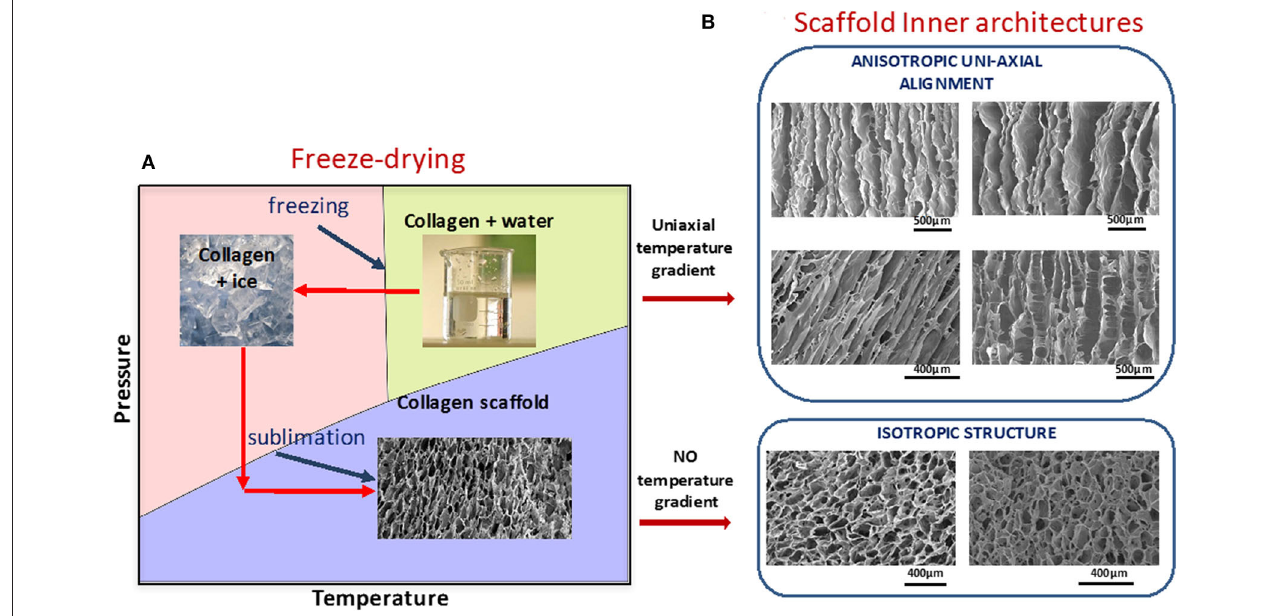
FIGURE 4 | (A) Schematic representation of freeze-drying process. Ice structure leads to pore shape, size, and orientation. (B) Examples of different morphologies of collagen scaffolds. Anisotropy in the microstructures were achieved by imposing temperature gradients during the phase of crystallization of water in collagen suspensions, using molding technology. Images from Cambridge Center for Medical Materials, University of Cambridge, UK are part of Figure 7 from Davidenko et al. (113). License for re-using these images had been obtained from Copyright holder